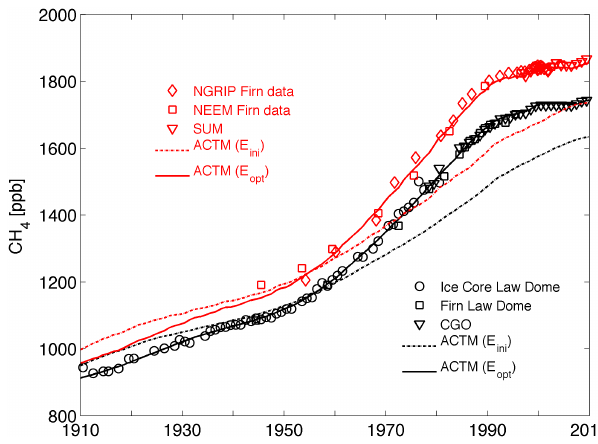
Figure 2. ACTM simulations of CH 4 concentration compared with ice core, firn and direct measurements. ACTM simulated CH 4 con- centrations with E ini ( E opt ) for the Arctic and Antarctic regions are shown in magenta (blue) and purple (green), respectively. The red (black) symbols and text are for the Arctic (Antarctic) region. Annual average ice core data (Law Dome: DSS, DE08 and DE08- 2), firn records (Law Dome (DE08-2 and DSSW20K); NGRIP firn data; and NEEM firn data) and direct observations (CGO: air archive, flask sampling and GAGE/AGAGE; SUM: flask sampling) are prepared and presented separately here. All the observation data are referenced to the Tohoku University (TU) CH 4 scale (Aoki et al., 1992; Umezawa et al.,